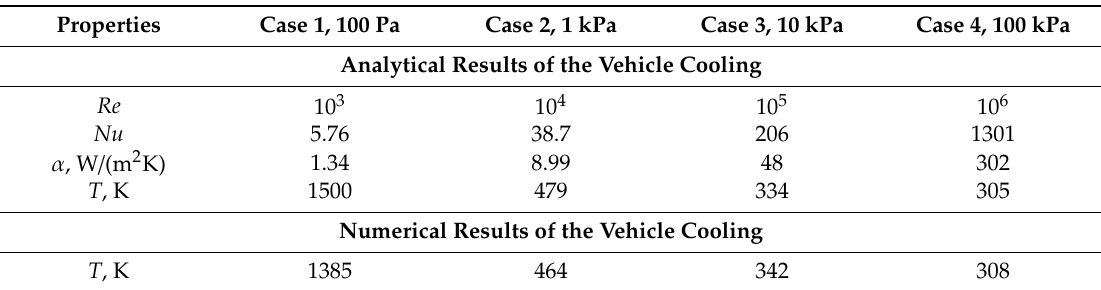
Table 3. Analytical and numerical results for the vehicle moving at 125 m / s and thermo-physical properties of air in the cooling duct estimated by analytical calculations and average hydraulic diameter of the duct d h = 0.115 m.